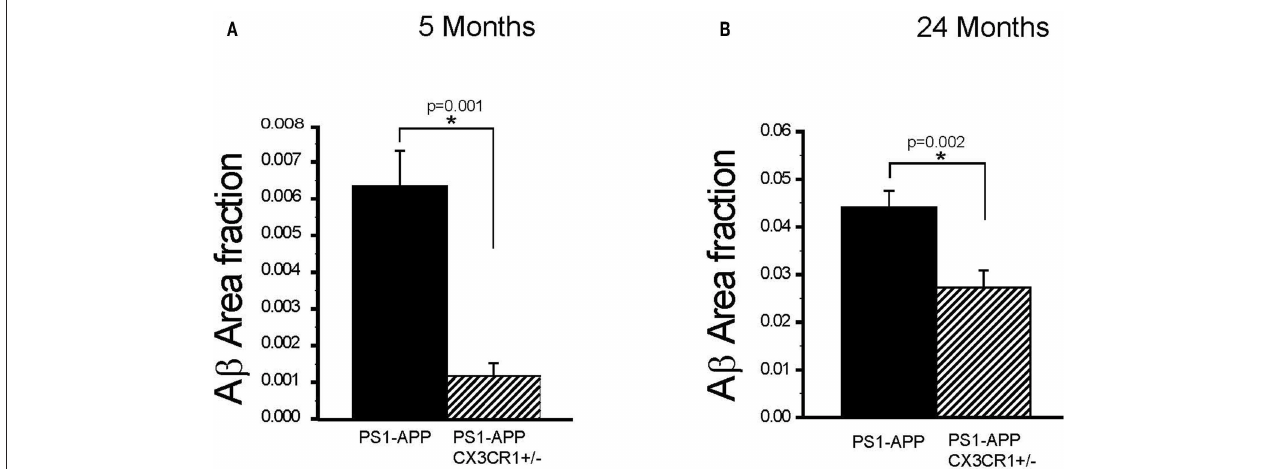
FIGURE 3 | CX3CR1 deficiency results in reduced plaque-load in 5- and 24-month old PS1-APP-CX3CR1 + / − mice. (A,B) Brain sections from PS1-APP and PS1-APP-CX3CR1 + / − mice at 5 and 24-months of age were stained and A β area fraction (A β AF) was determined for hippocampus + cortex in mice at 5 and 24-months of age. (A) At 5 months of age A β AF is significantly reduced in PS1-APP-CX3CR1 + / − ( n = 3) mice compared with PS1-APP mice ( n = 8). (B) At 24- months of age, A β AF is also significantly reduced in PS1-APP-CX3CR1 + / − ( n = 5) mice compared with PS1-APP mice ( n = 6). For all groups three sections per mouse were quantified and numbers represent group mean ± SEM. * represent statistically